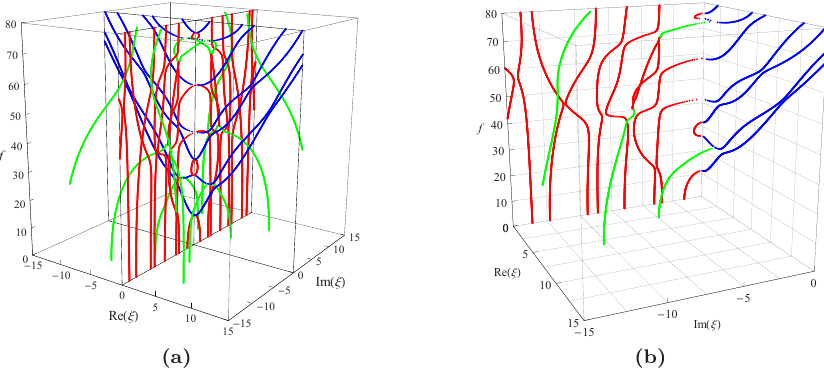
Figure 4. Full dispersion spectra of complex Rayleigh waves for a nonhomogeneous magneto-electro- elastic half-space: ( a ) 3D full frequency spectra; ( b ) one quarter of the 3D full frequency spectra. Nonhomogeneous coefficient n = 1, ξ = k × 10 2 ; blue branches for real solutions, red for imaginary, green for complex.